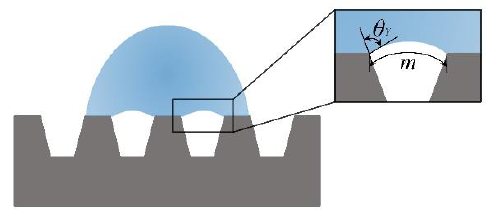
Figure 5. Schematic diagram of gas-liquid interface contact line.